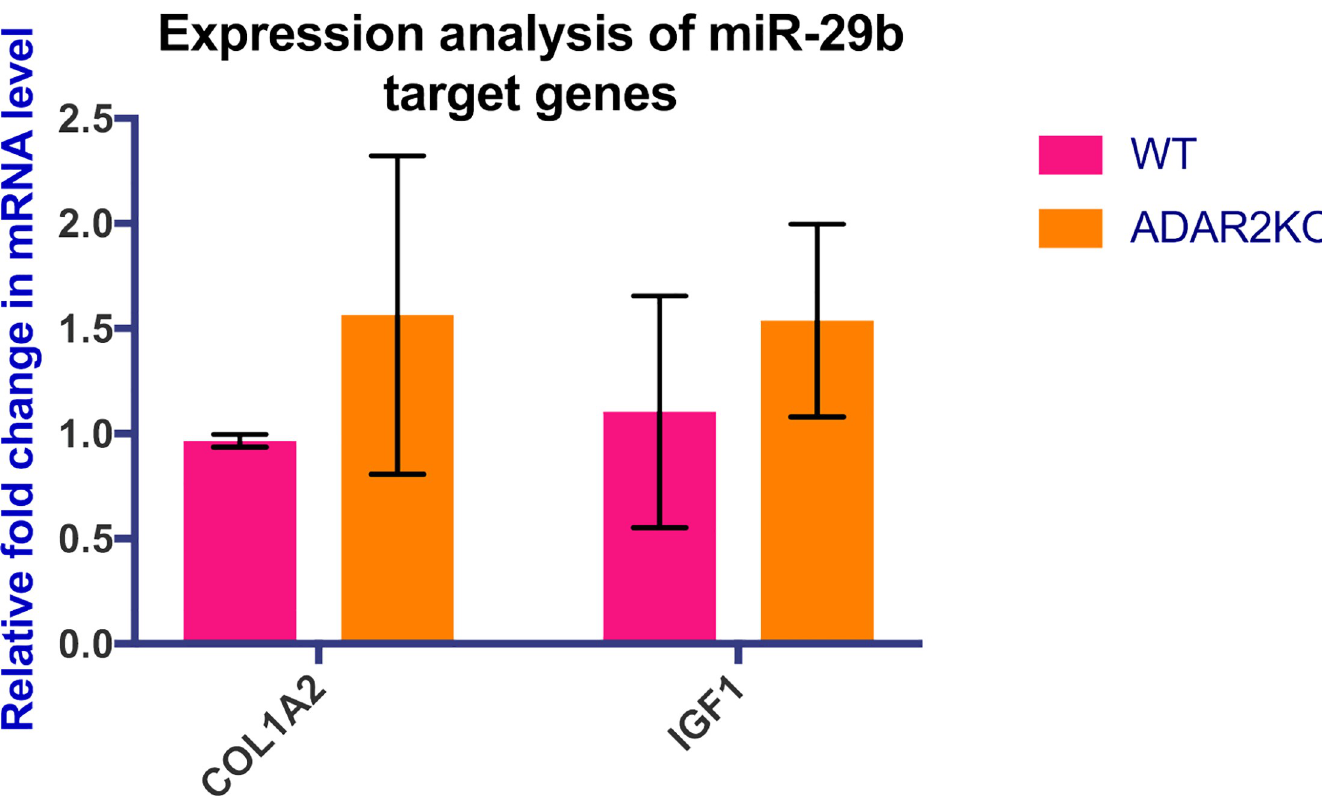
Fig 3. Expression analysis of the miR-29b target genes COL1A2 and IGF1 from ADAR2-KO mouse hearts in three different biological replicates. COL1A2 and IGF1 are cardiac hypertrophy and fibrosis related miR-29b target genes. miR-29b has been found downregulated ~2.0 fold in the absence of ADAR2. Bar graph showing slight but not significant changes in the expression of these genes. The error bars indicate the mean +/-SD. � P < 0.05 (versus control), as determined by the Mann– Whitney U